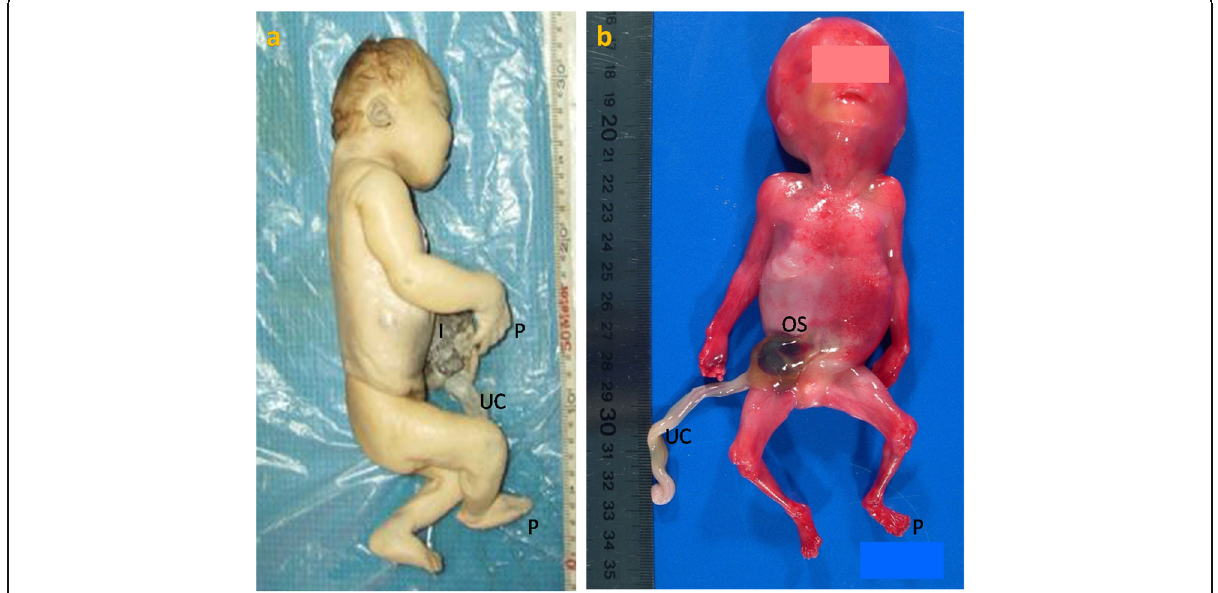
Fig. 2 Omphalocele in fetuses with trisomy 13. a Male Congolese fetus born dead. Ruptured omphalocele (o) with eviscerated small intestines (i) and umbilical cord (UC) inserted in the omphalocele. Dysmorphic facies with microcephaly, cleft lip, ears down inserted. Bilateral postaxial polydactyly (P) of hands and feet. b Male French fetus after termination of pregnancy. Intact omphalocele (o), dysmorphic facies with microcephaly, cleft palate, low set ears, postaxial hexadactyly of hands and